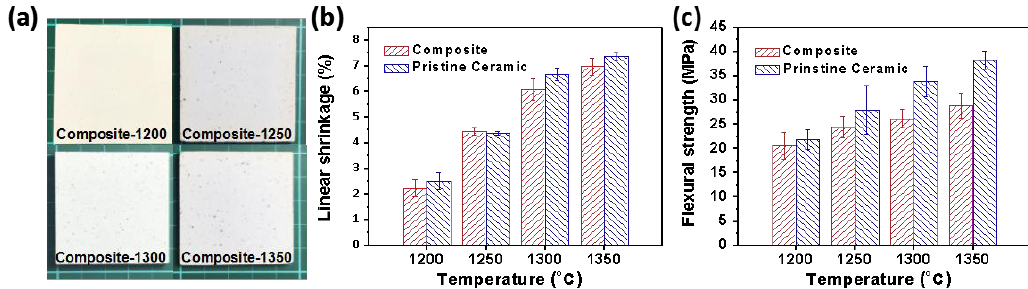
Figure 4. ( a ) Optical pictures, ( b ) linear shrinkage, and ( c ) flexural strength of specimens fired at different temperatures.